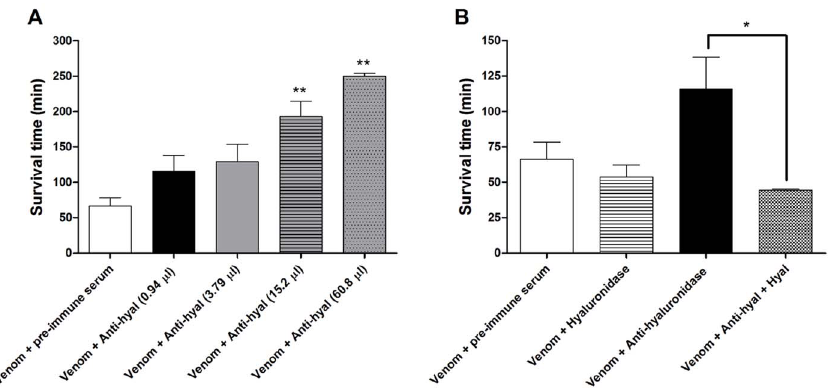
Figure 6. Invivo neutralization assays using rabbit anti-hyaluronidase serum. (A) Survival times of mice within 24 h of subcutaneous injection of Tityus serrulatus venom (1 LD 50 , 13.2 m g) samples that had been incubated for 1 h at 37 u C with pre-immune serum (121.6 m l) or different quantities of anti-hyaluronidase serum (0.94–60.8 m l) were evaluated. ** p , 0.01 (venom + anti-hyaluronidase group vs. venom + pre-immune serum group). (B) Survival times of mice within 24 h of subcutaneous injection of Tityus serrulatus venom (13.2 m g) samples pre-incubated with 0.94 m l of anti-hyaluronidase serum for 1 h at 37 u C, with or without the subsequent addition of native Tityus serrulatus hyaluronidase (0.418 m g). Mice were also injected with Tityus serrulatus venom (13.2 m g) pre-incubated with pre-immune serum (121.6 m l) and Tityus serrulatus venom (13.2 m g) supplemented with native hyaluronidase (0.418 m g), and these mice served as controls. * p , 0.05 (venom + anti-hyaluronidase serum group vs. venom + anti- hyaluronidase serum + native Ts hyaluronidase group). All values are the mean 6 S.E.M. of at least 4 experiments.